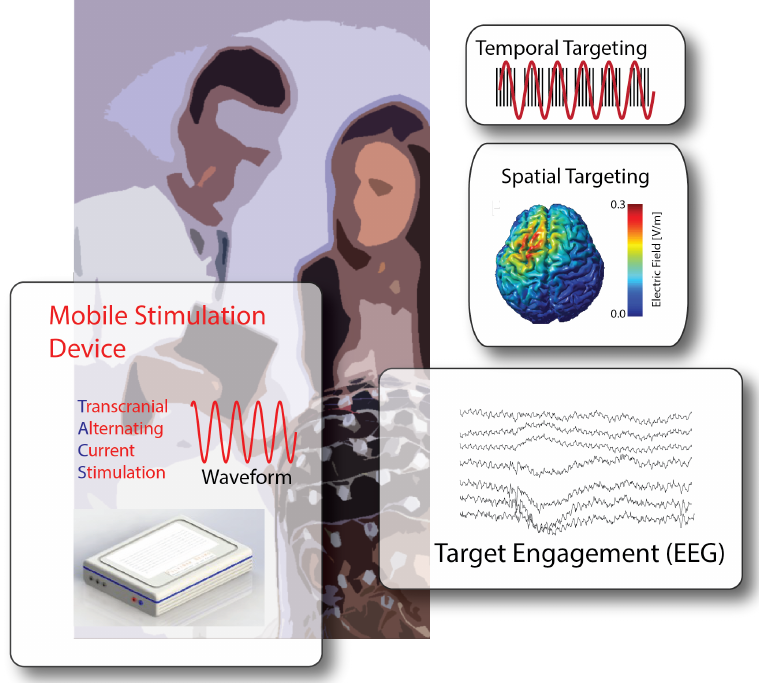
Figure 6. Non-invasive brain stimulation by transcranial alternating current stimulation (tACS) modulates brain rhythms by entrainment (temporal targeting). The spatial spread of the electric field is determined by the montage of the electrodes (spatial targeting). The stimulation waveform is a sine wave tuned in frequency to the targeted network oscillation. Target engagement (and closed-loop stimulation) is based on EEG. The tACS technology is safe, lightweight, easy to apply, cost effective and, therefore, ideal for future at-home